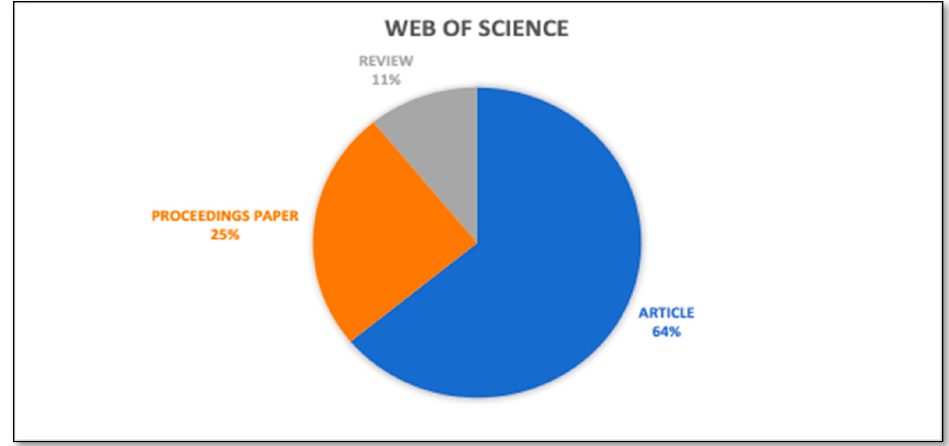
11 of 38 Figure 7. Analysis of documents by type. (Scopus database). Table 5. Publication count by document type (Scopus database).